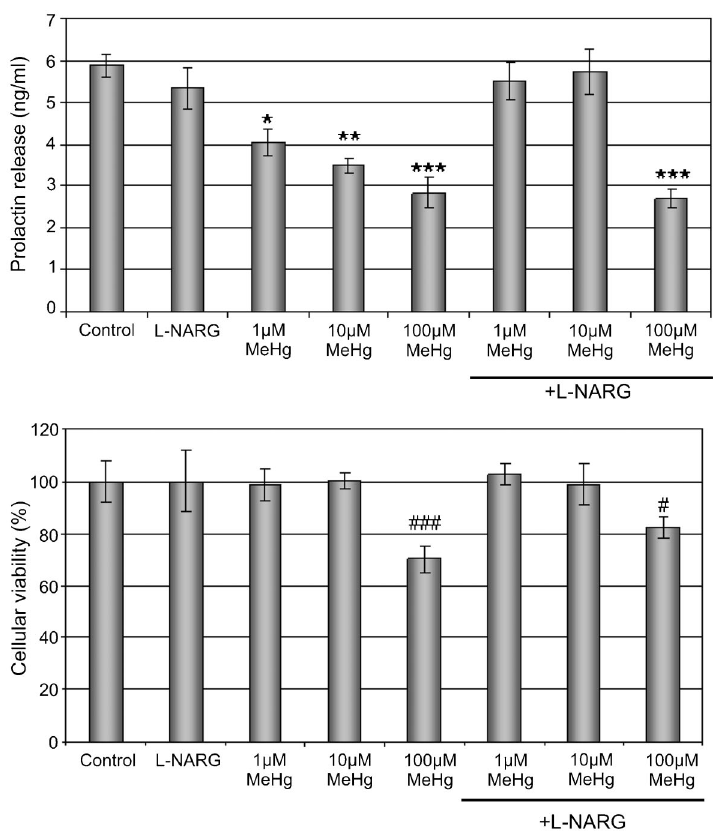
Figure 2. Prolactin release ( top panel ) and cellular viability ( bottom panel ) of the rat pituitary cell line GH3B6 exposed to different methylmer- cury (MeHg) concentrations and/or 3 mM N- nitro-L-arginine (L-NARG) for 2 h. Data are reported as means ± SE (n=6). *P , 0.05, **P , 0.01, and ***P , 0.001 vs control and groups incubated with L-NARG and L-NARG ++ MeHg (1 and 10 m M); # P , 0.05 and ### P , 0.001 vs all groups except those incubated with 100 m M MeHg and L-NARG ++ 100 m M MeHg (ANOVA with Tukey’s